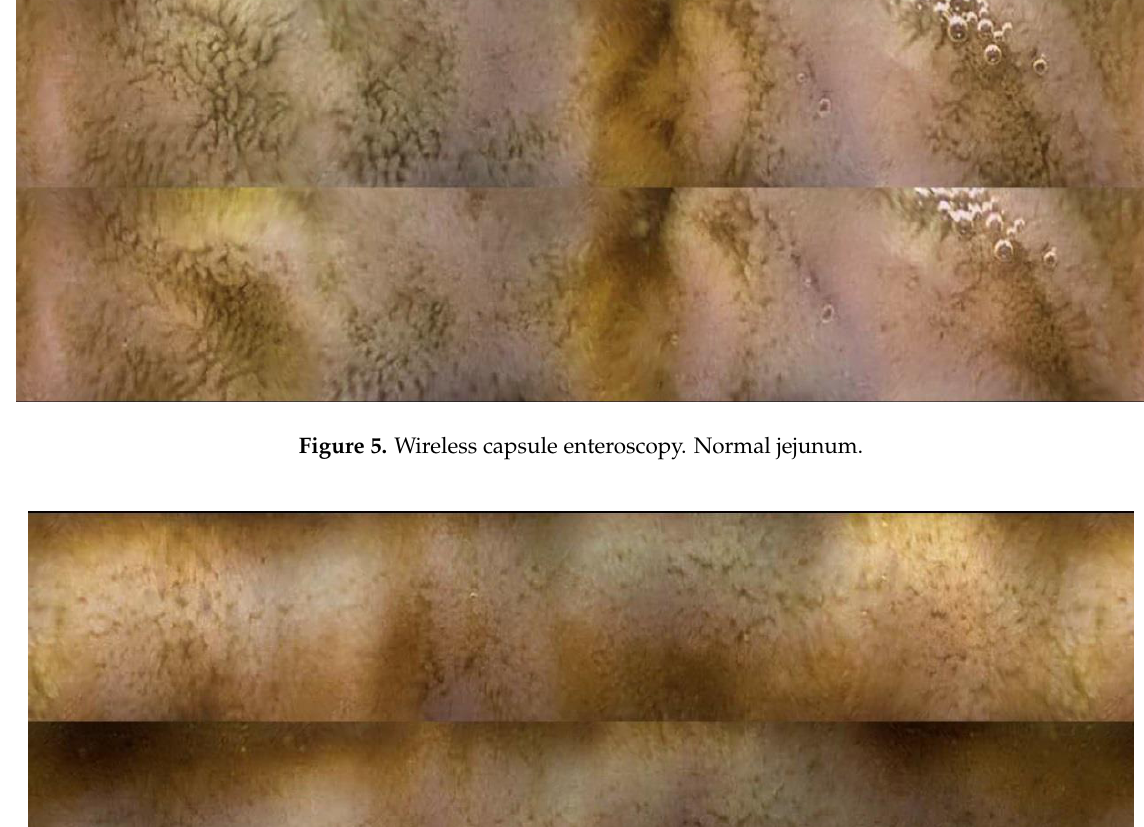
Figure 4. Electrogastrography. EGG power before and after a single intragastric administration of 24 mg galantamine in animals with previous 7-day administration of dextran sodium sulphate (mean + standard deviation). Outliers omitted. Axis Y: natural logarithm scale. Explanatory note: Bas: 15-min basal recording before galantamine administration; t: 15- min study recordings after galantamine administration (t1: time interval between 0–15 min ... t20: time interval between 286–300 min).